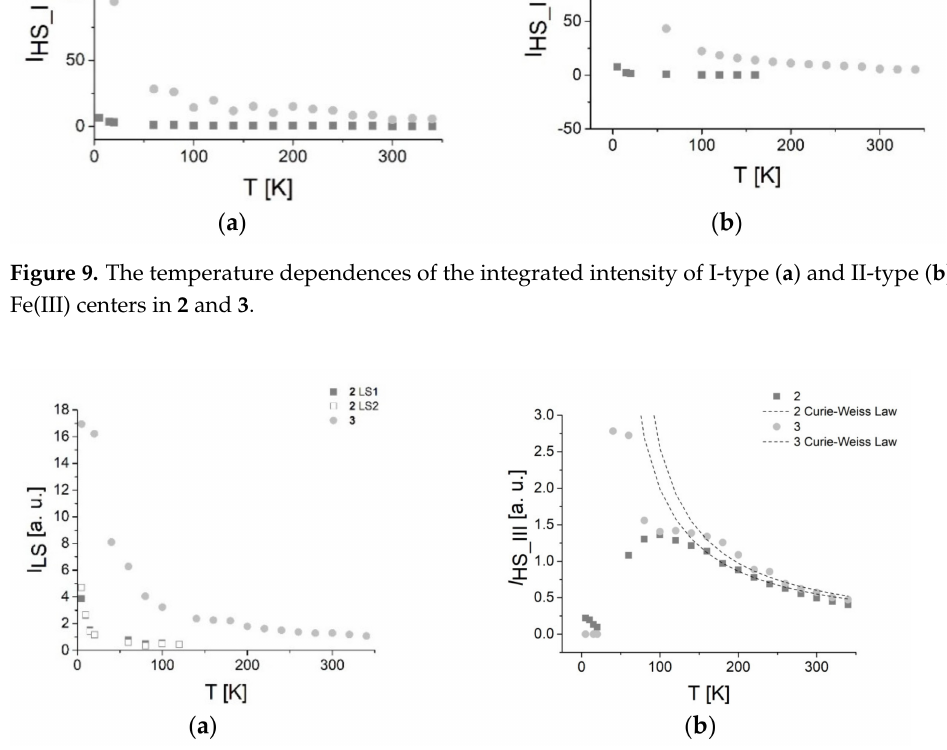
Figure 10. The temperature dependences of the integrated intensity of LS ( a ) and III-type HS ( b ) Fe(III) centers in 2 and 3 . The dashed lines are calculated within the Bonner–Fisher model for antiferromagnetically coupled